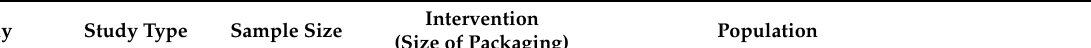
Table 1. Summary